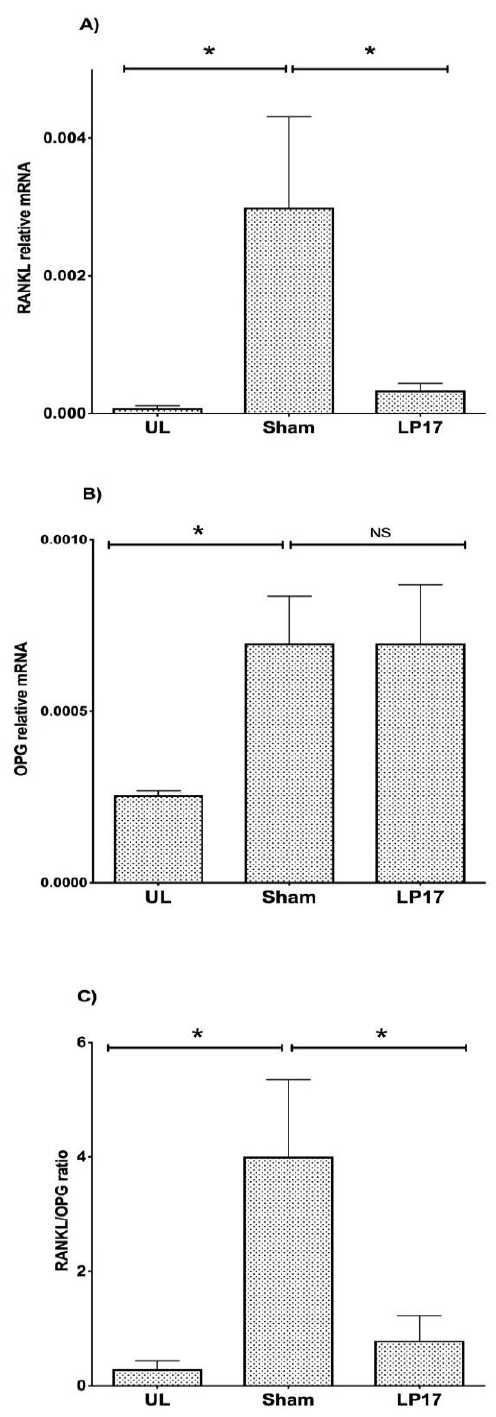
Figure 5. Inhibition of receptor activator of nuclear factor kappa-B-ligand (RANKL) / osteoprotegerin (OPG) ratio by LP17. Gingival tissue samples were dissected at day 5 from mice used in Figure 2 and were processed for gene expression of RANKL (A) and OPG (B) by qPCR. The relative RANKL / OPG ratio was also calculated (C) . The expression of the indicated molecules was determined in unligated (UL) control gingiva and in ligated gingival tissues treated with 5 µ g synthetic TREM-1 inhibitor (LP17) or PBS sham. The gene expression levels were detected by TaqMan real-time qPCR and calibrated against the expression of the housekeeping gene β -actin . Results are means ± SEM ( n = 4 mice / group). * p < 0.05 and ** p < 0.01 between the indicated groups. NS: Not significant, p > 0.05.